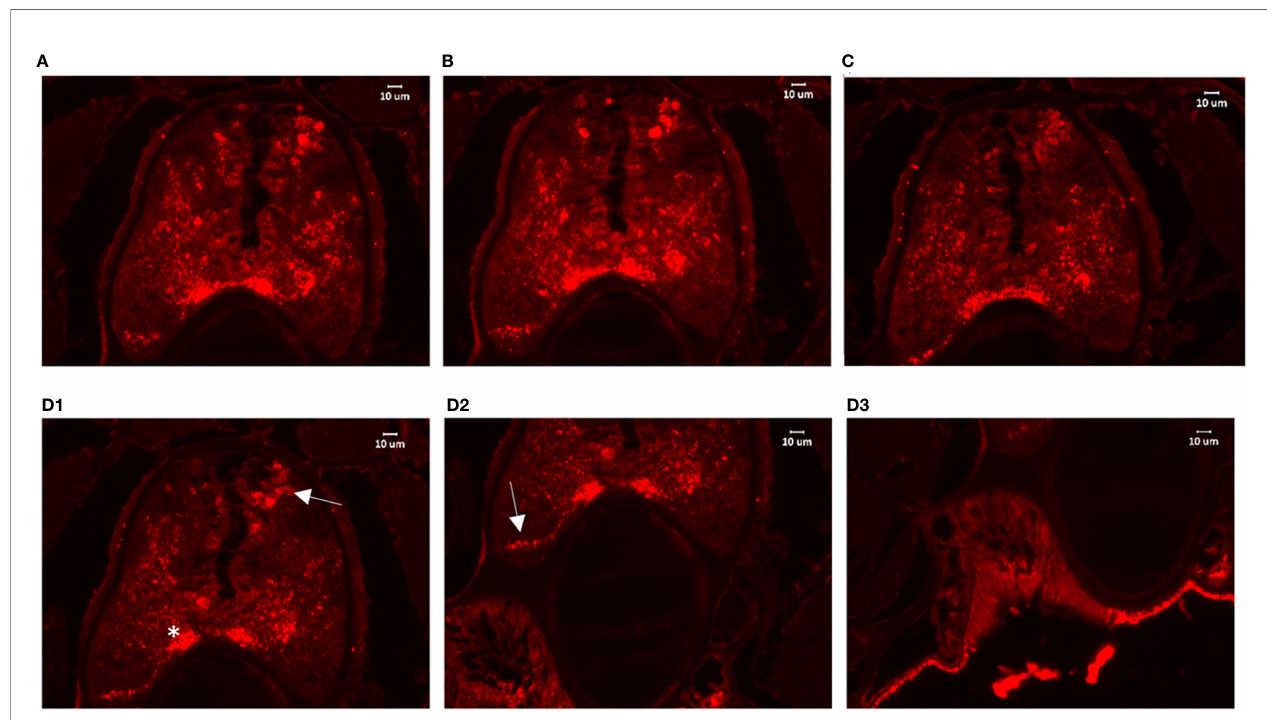
FIGURE 4 | Detection of PACAP/GCGa in the anterior nerve cord of B . belcheri after high salinity challenge. Animals were exposed to 35 ppt ASW for 72 h The digitalimages represent a series of 4 consecutive transverse sections(from (A) heanterior part to (D) posterior part) within the Hatschek ’ s pit region. (D) Representative images for PACAP/GCGa distribution on different regionsof the same section (D1 – D3) . In (D1) , the arrow and asterisk indicateintense staining reaction inthe dorsal Joseph cells and in the region close to the nucleus of Rodhe. The arrow in (D2) indicates the intense staining reaction in the infundibulum-like downgrowth approachingthe Hatschek ’ s pit. The scale bar is10 m m and isindicated inthe fi